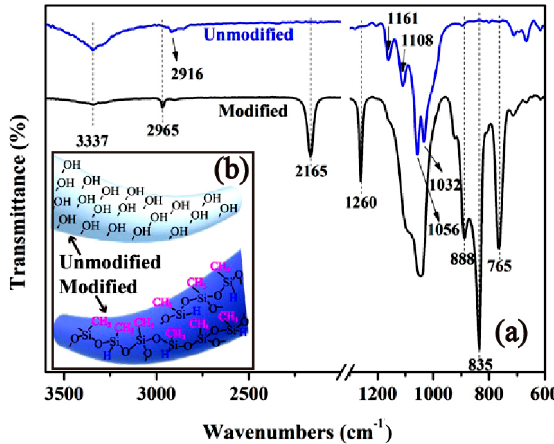
Figure 1. The Fourier transform infrared spectroscopy (FTIR) spectra ( a ) and schematic representation ( b ) of pristine and PMHS-modified cotton fabric. Modified cotton fabric was modified by modifier solution with a PMHS concentration of 1.00% and then washed with hexane three times.